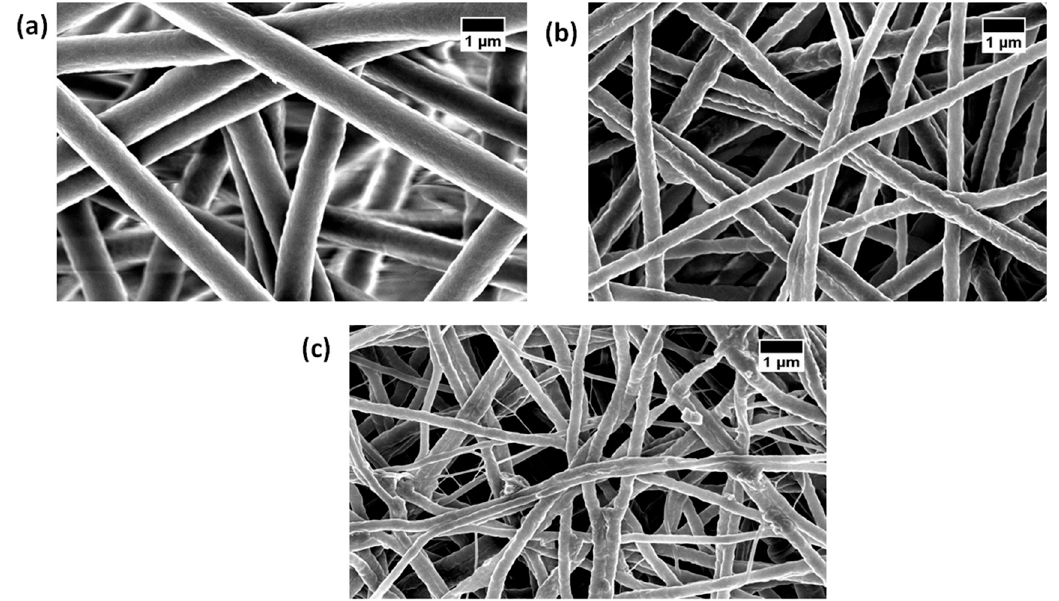
Figure 1. Field Emission Scanning Electron Microscopy (FESEM) images of ( a ) polyurethane (PU), ( b ) PU / ylang ylang (YY) and ( c ) PU / YY / zinc nitrate (ZnNO 3 ) .